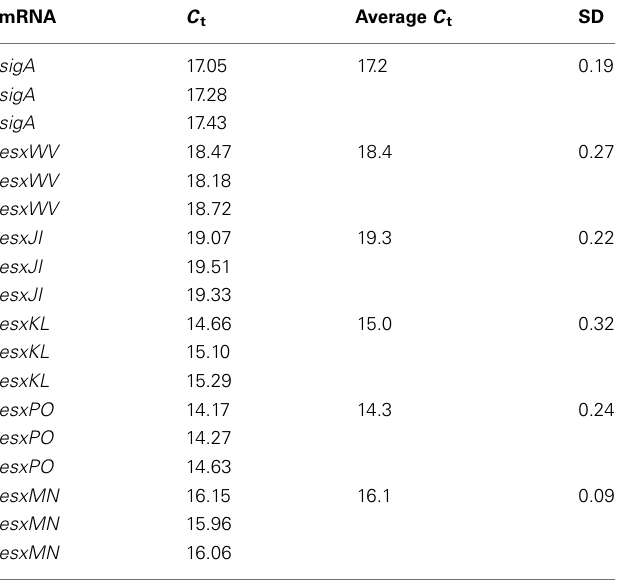
Table 3 | QILSS–Mtb9.9 family mRNA are expressed at different levels.